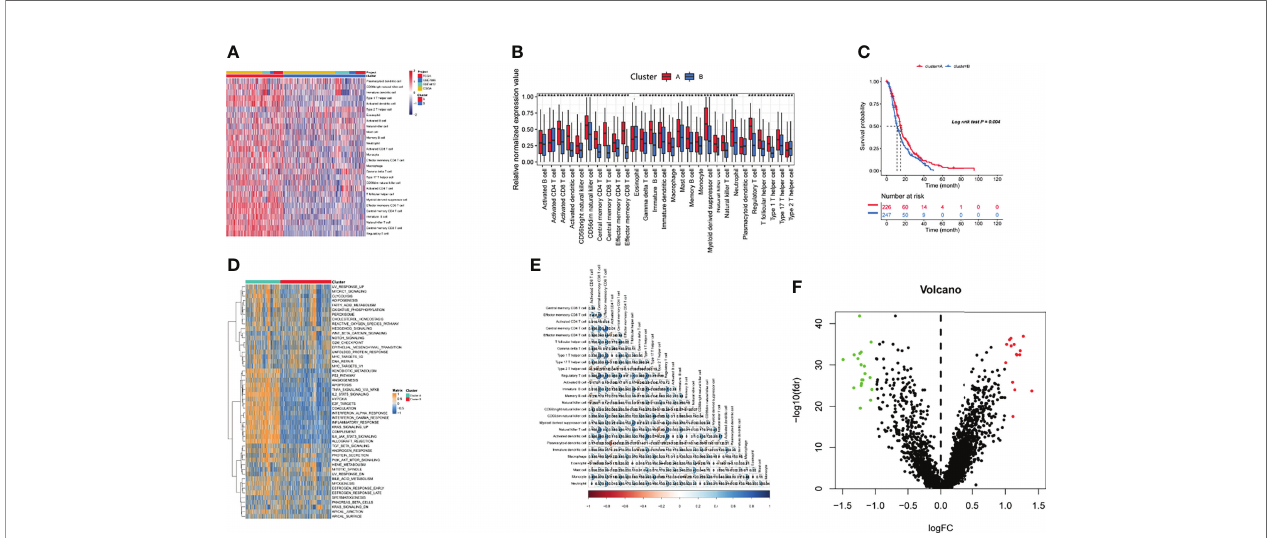
FIGURE 1 | Identi fi cation of immunogenic subtypes. (A) Landscapes for the 28 in fi ltrating immune cell types of both clusters. (B) The distribution of tumor-in fi ltrating immune cells in the two clusters. (C) Survival analysis of the two clusters. (D) Heatmaps of 50 hallmark pathways with differential activation in different clusters. (E) The correlations with different immune cells. (F) Differentially expressed genes in the two clusters. (***p ≤ 0.001).